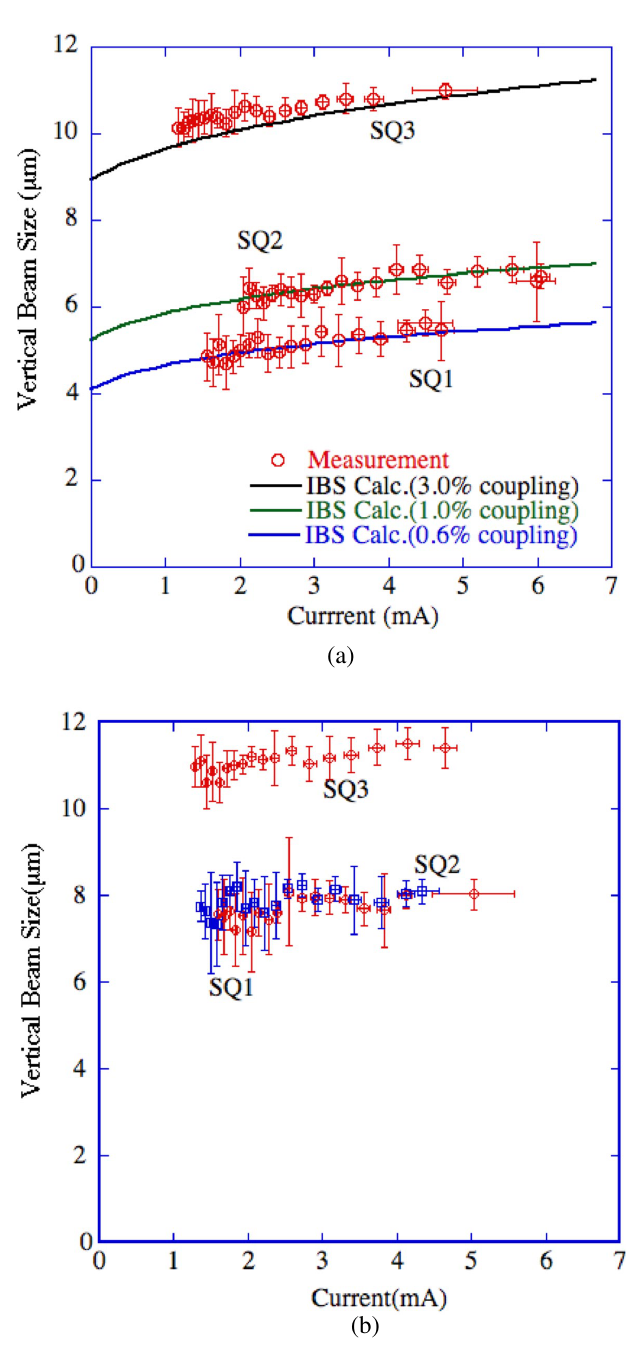
FIG. 9. (Color) (a) Vertical beam size as a function of the stored current measured with Herschelian reflective optics. (b) Vertical beam size as a function of the stored current measured with refractive